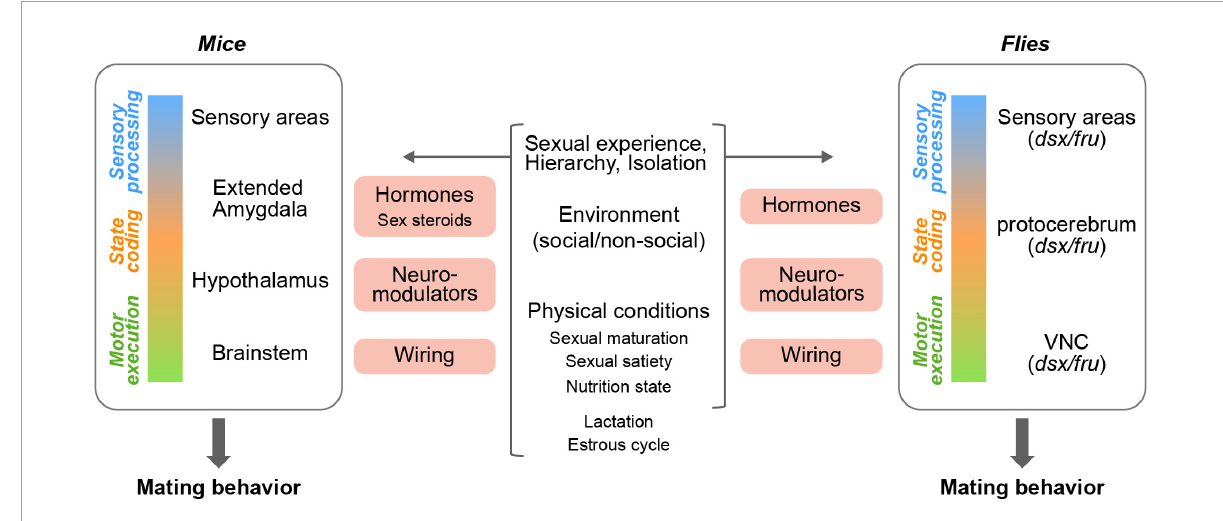
FIGURE2 Circuit nodes in mating neural circuits that are influenced by internal and external factors. Diverse internal and external factors (middle) affect mating neural circuits through various mediators (pink boxes) at different levels (left and right) in both mice and